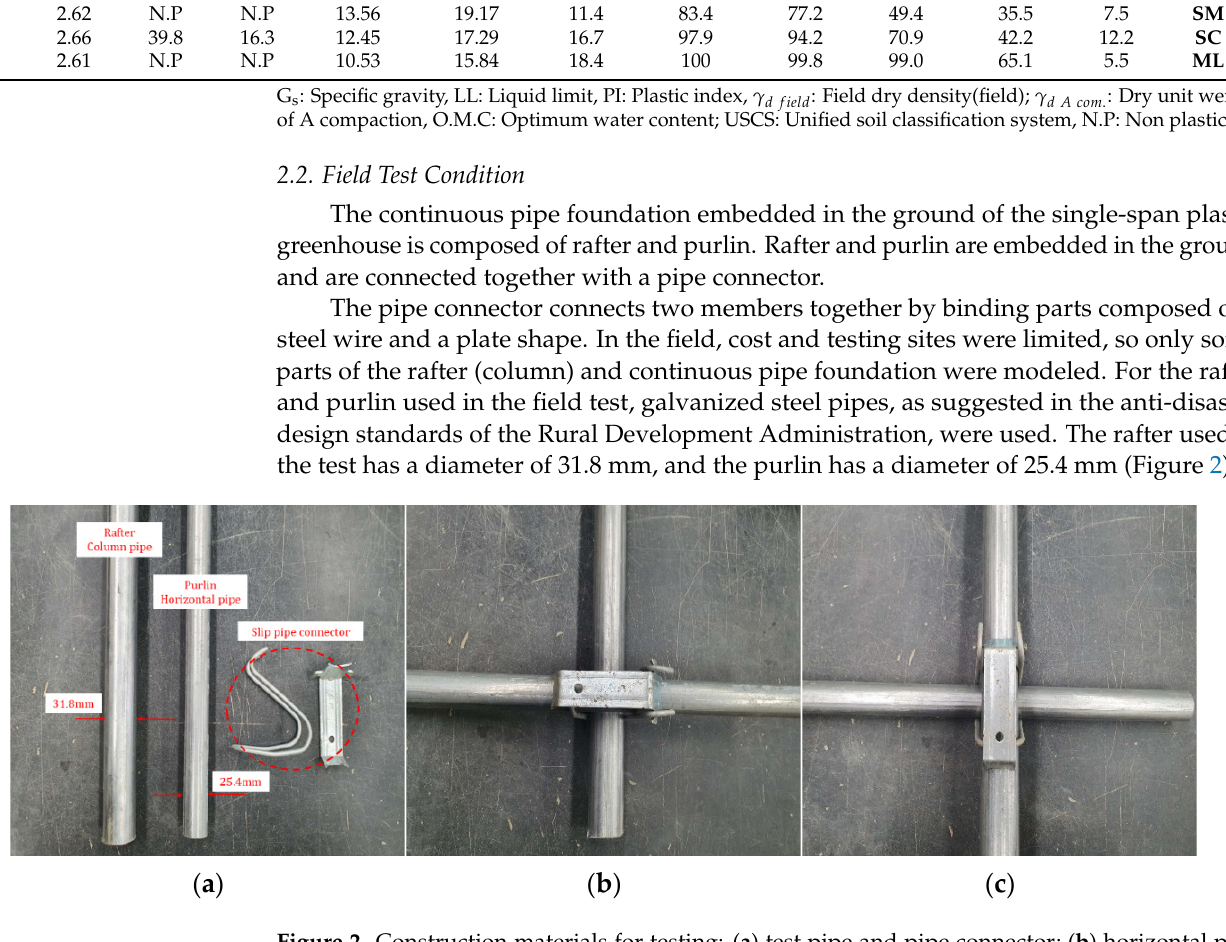
Table 1. Mechanics and physical properties of soils on site A, site B, and site C.